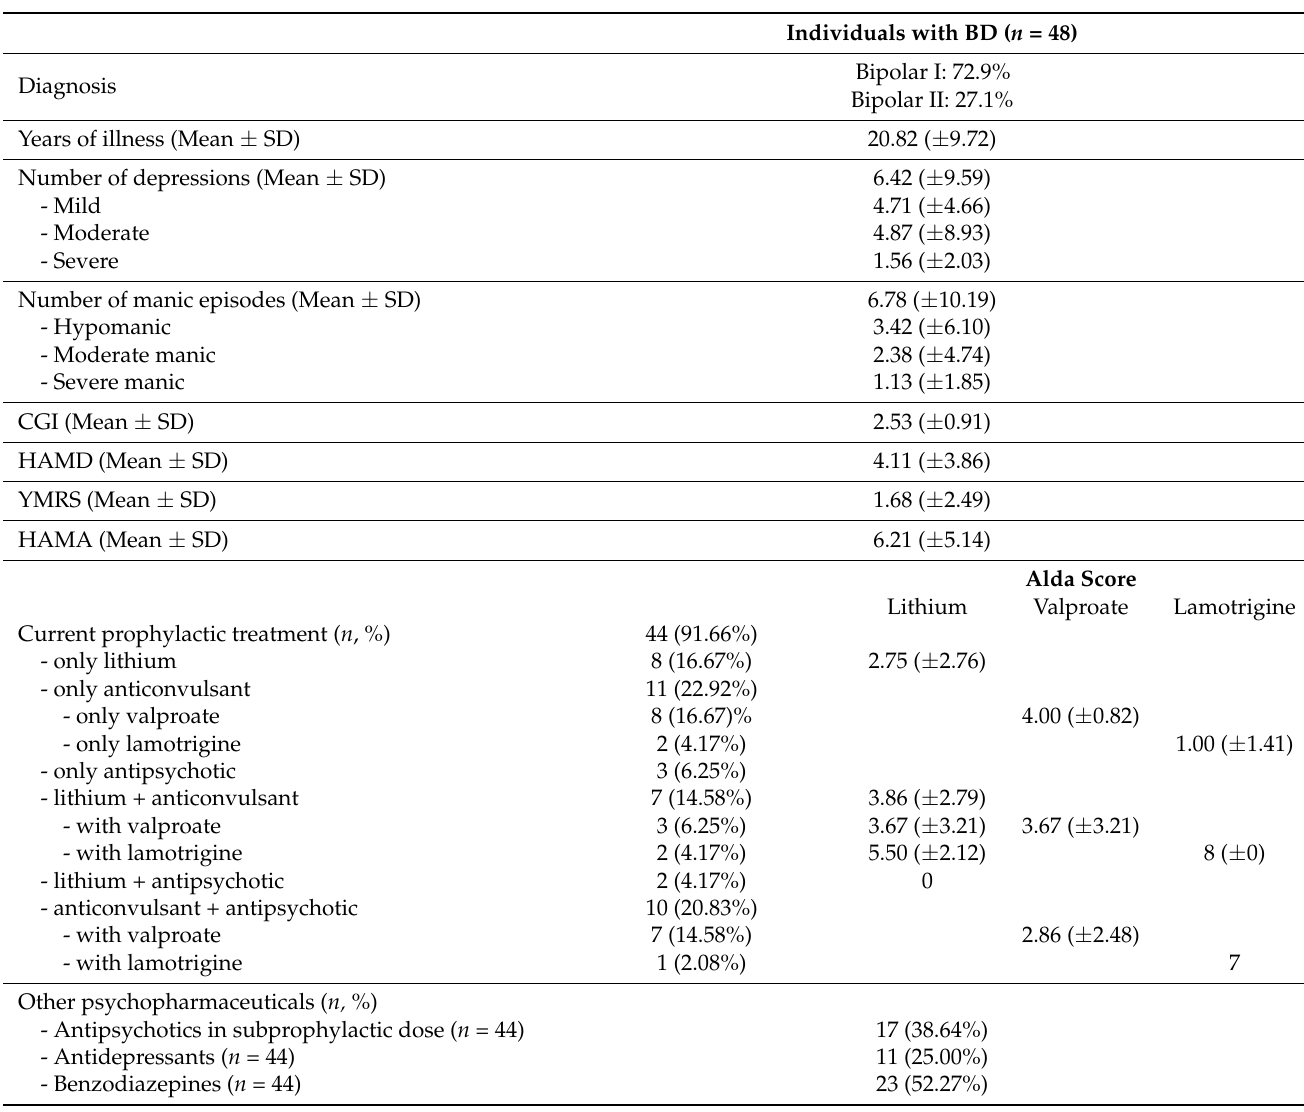
Table 2. Clinical variables and mood-stabilizing treatment of participants with BD.